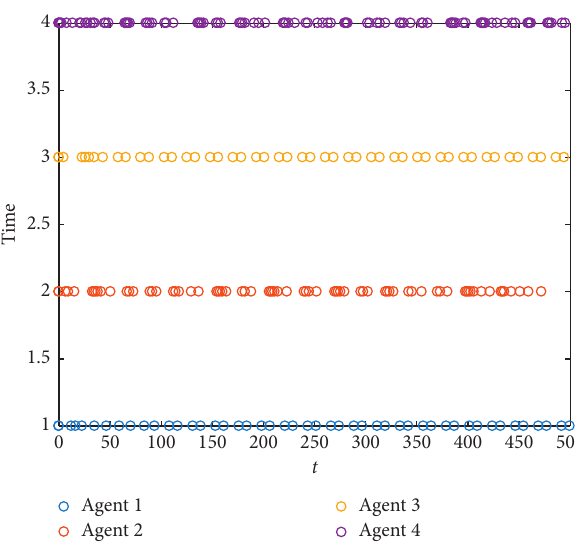
Figure 6: The event-triggered time for containment